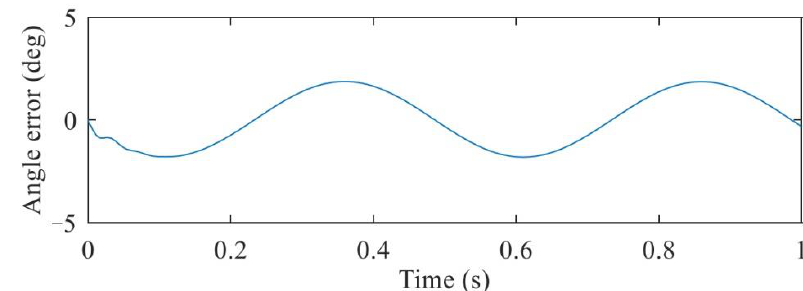
Figure 12. HIL simulation error curve with PID control.